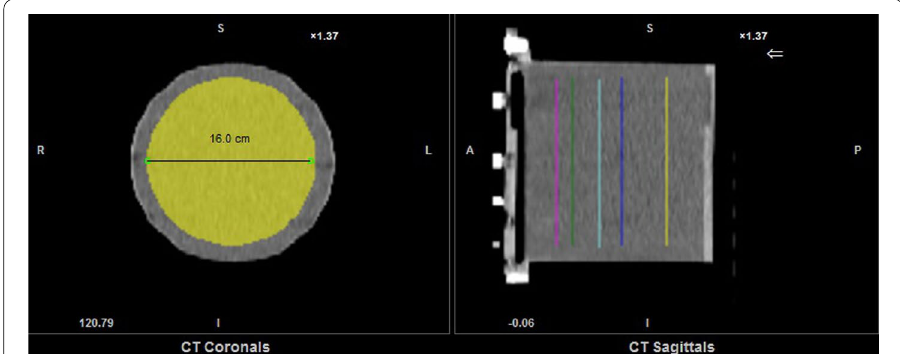
Fig. 1 Image of the uniform cylindrical phantom with 5 circular regions of interest of 16 cm in diameter located at different levels along the long axis of the phantom, reconstructed with Q.Metrix application of Xeleris 2 software from GE